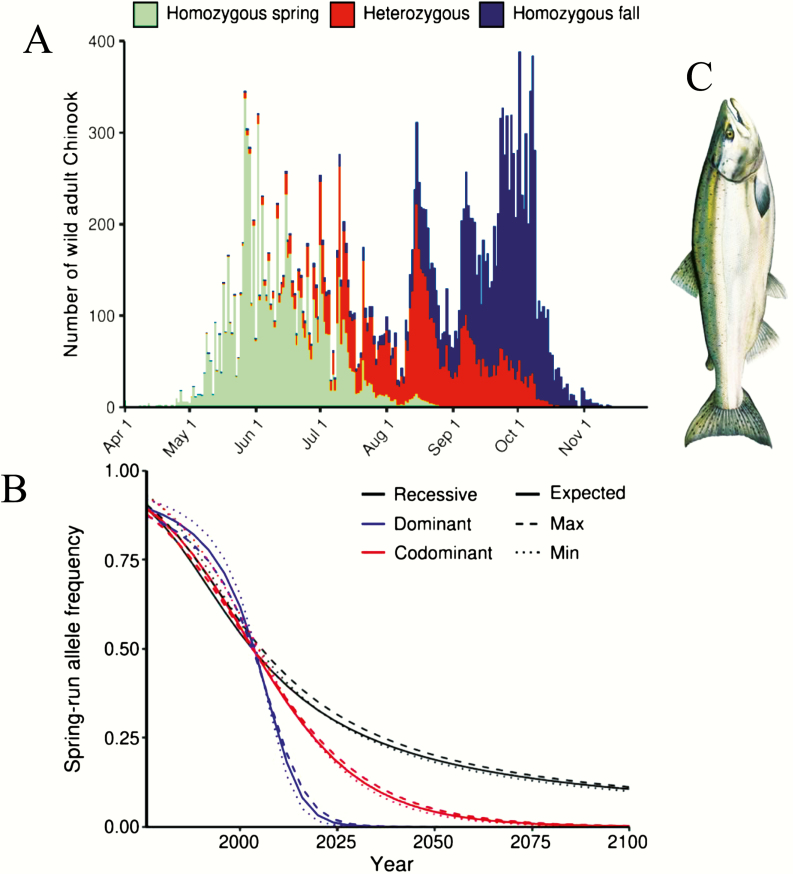
(A) Stacked bar graph representing the number of wild adult Chinook salmon passing Gold Ray Fish Counting Station on the Rogue river in 2004; colors represent estimated proportion of each GREB1L locus genotype. (B) Selection modeling in Rogue Chinook. Curves representing the decline (or loss) of the spring-run allele frequency over time under a recessive, dominant, or codominant scenario. Spring-run alleles are thought to be codominant and predicted to be lost by ~2075. The modeling assumes random mating and no genetic drift. (C) Image of a Chinook salmon. Figure modified from Thompson et al. (2019). See online version for full colors.